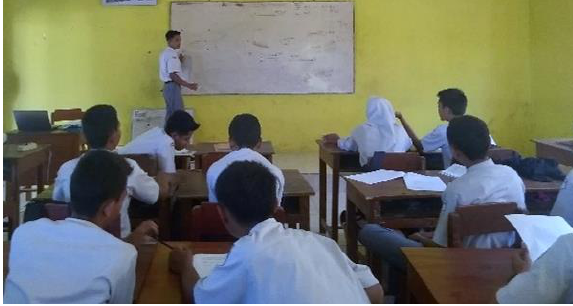
Figure 7: Student present practical results.